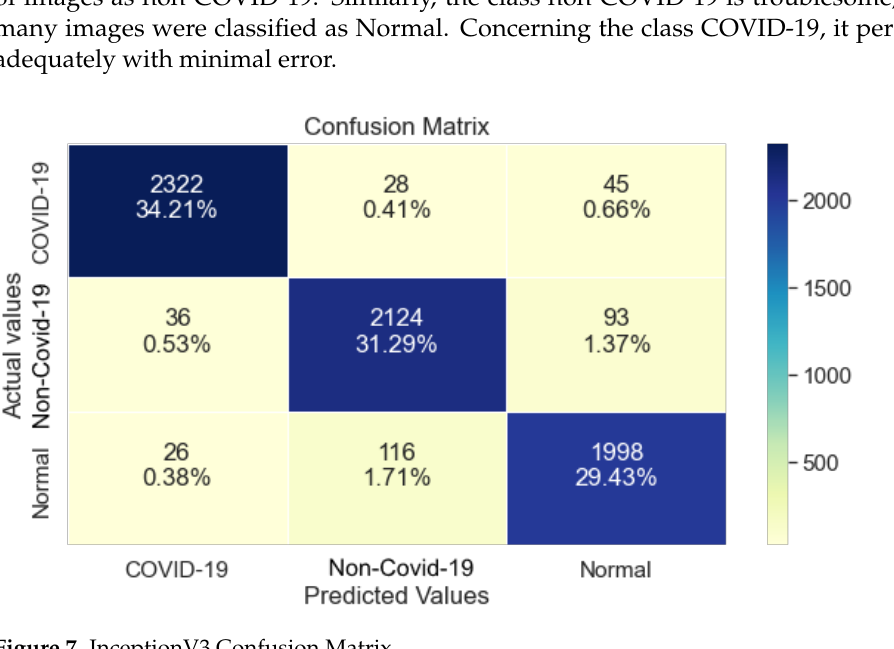
Table 8. Compiled Results from all models.